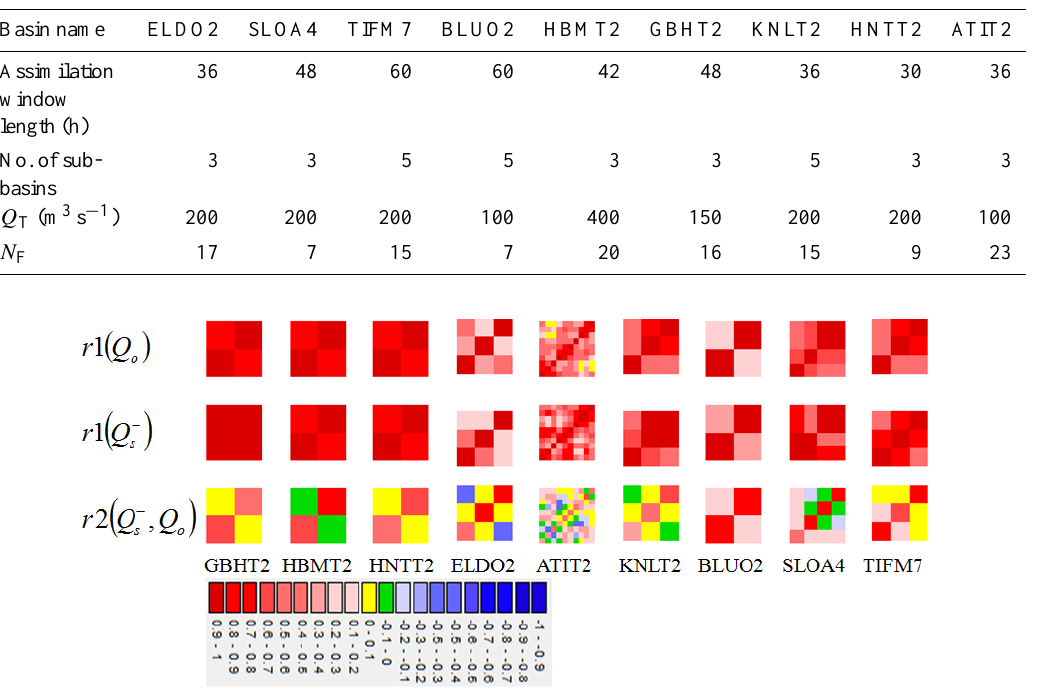
Table 2. The length of assimilation window, the number of sub-basins delineated from the channel connectivity map, the number of flood events denoted as N F and the threshold of streamflow ( Q T ) used to identify flood events.